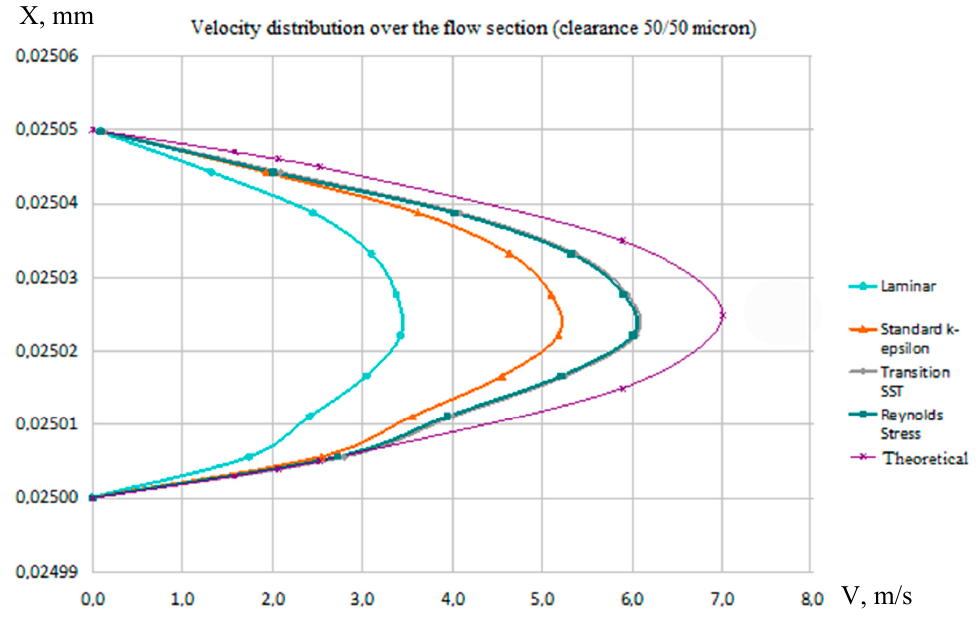
Figure 6. Velocity distribution over the flow section.